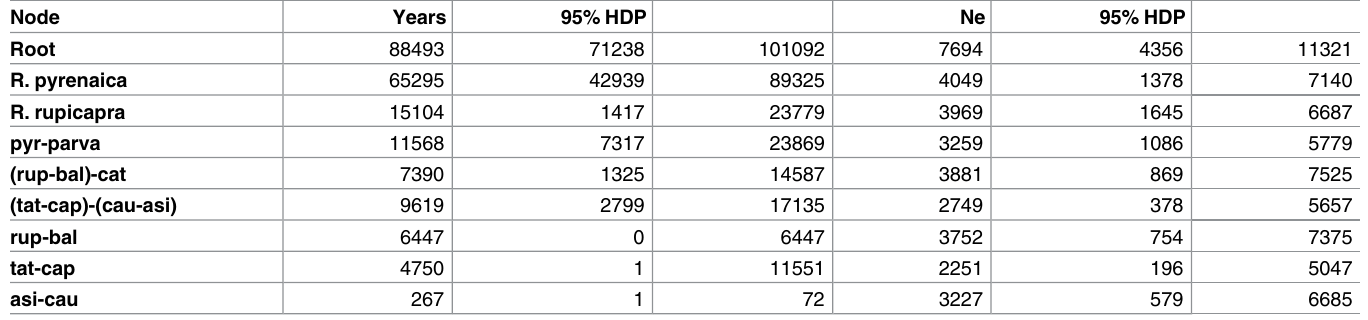
Table 3. Node ages and effectivepopulation sizes (Ne).